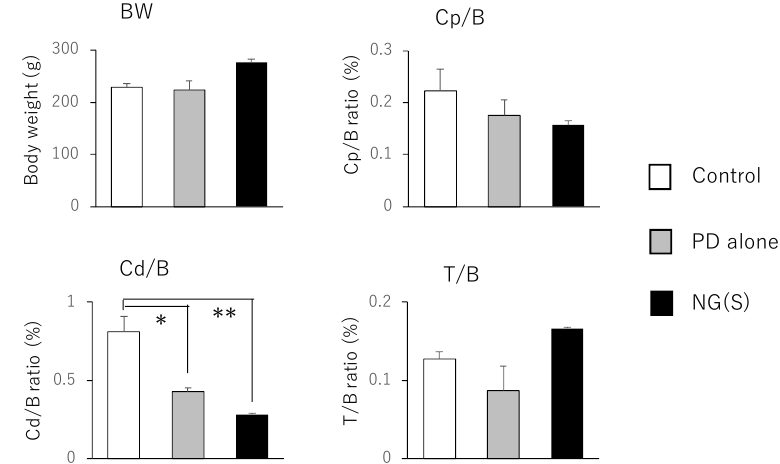
Figure 8. Parameter values associated with efficacy and toxic side effect at 5 mg PD eq./kg. BW, B: body weight, Cp: proximal colon weight, Cd: distal colon weight, T: thymus weight. The results are expressed as the mean ± S.E. ( n = 3). * p < 0.05, ** p < 0.01.